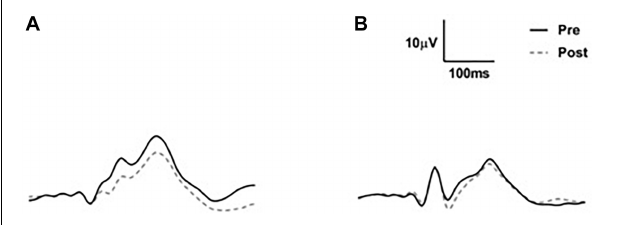
FIGURE 4 | Group average VEP waveforms in microvolts. (A) Average VEP waveforms across all three electrodes for the young adult group. (B) Average VEP waveforms across all three electrodes for the older adult group. Note that there was considerable between-subject variability (not shown).